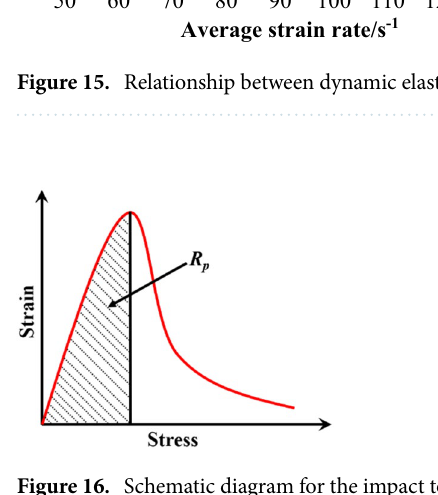
Figure 16. Schematic diagram for the impact toughness of